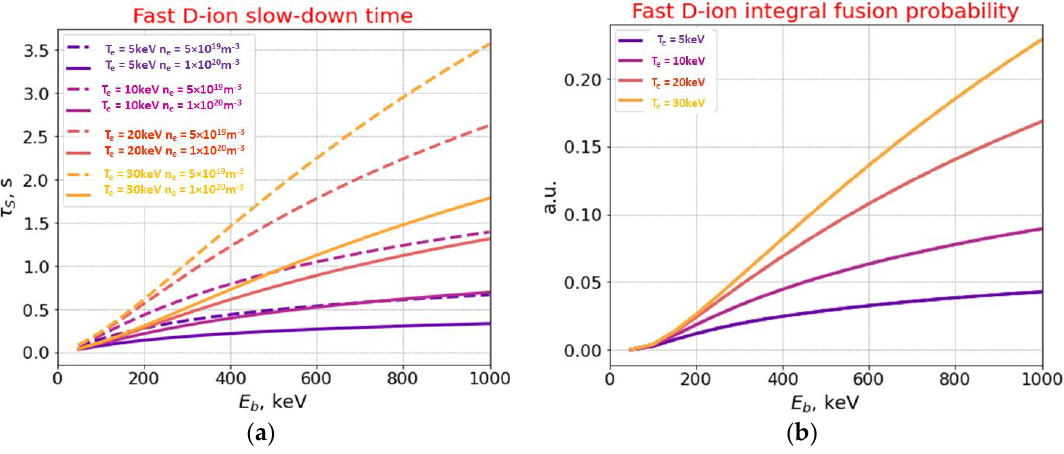
Figure 2. Energy dependence of fast D+ ion slow-down time ( a ) and integral neutron production ( b ), calculated for T e = 5, 10, 20, and 30 keV and n e = 0.5 × 10 20 m −3 (dotted) and n e = 1 × 10 20 m −3 (solid).